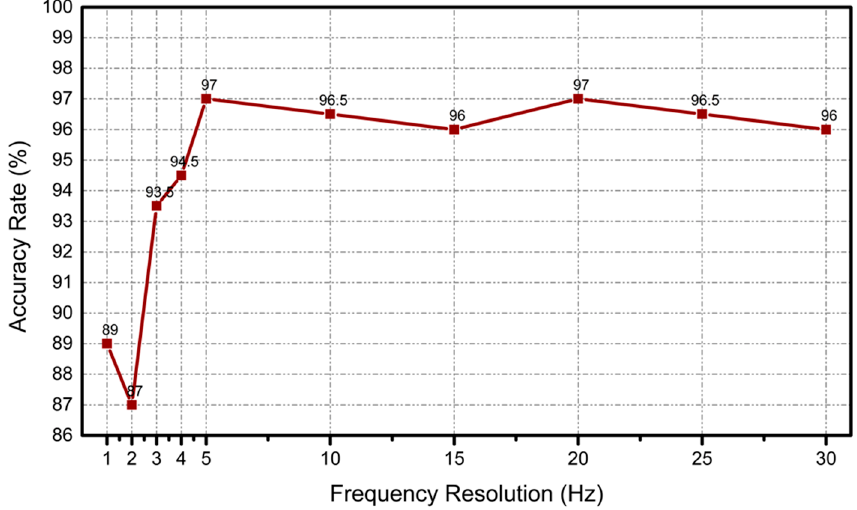
Figure 9. The recognition accuracy rate at different frequency resolutions in the low resolution range.